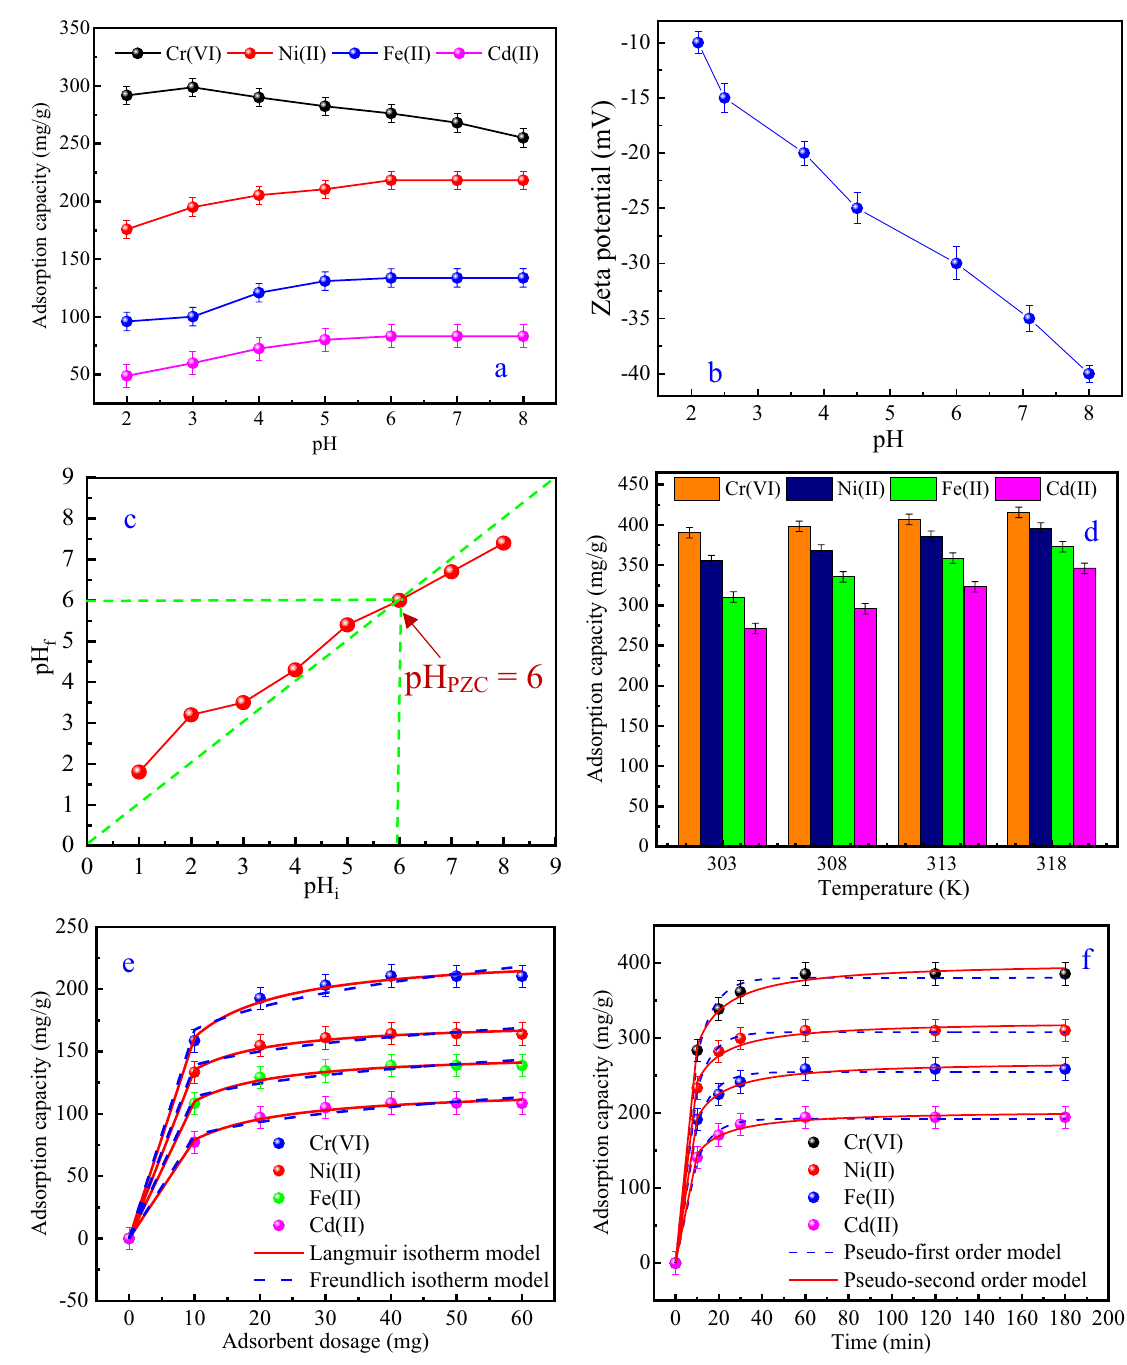
Figure 3. (a) Effect of pH on the adsorption of metal ions by MWCNTs-KIAgNPs; (b) point of zero charge pH (pH PZC ) of MWCNTs-KIAgNPs; (c) zeta potentials of MWCNTs-KIAgNPs; (d) influence of temperature on the uptake of Cr(VI), Ni(II), Fe(II) and Cd(II) ions by MWCNTs-KIAgNPs; (e) Langmuir and Freundlich isotherm model curves of MWCNTs-KIAgNPs adsorption towards Cr(VI), Ni(II), Fe(II) and Cd(II); (f) pseudo-first order and pseudo-second order kinetic model for Cr(VI), Ni(II), Fe(II) and Cd(II) adsorption by MWCNTs-